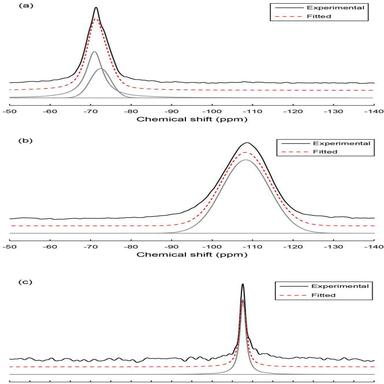
Solid-state 29Si NMR spectra of (a) raw cement, (b) silica fume, and (c) silica powder.